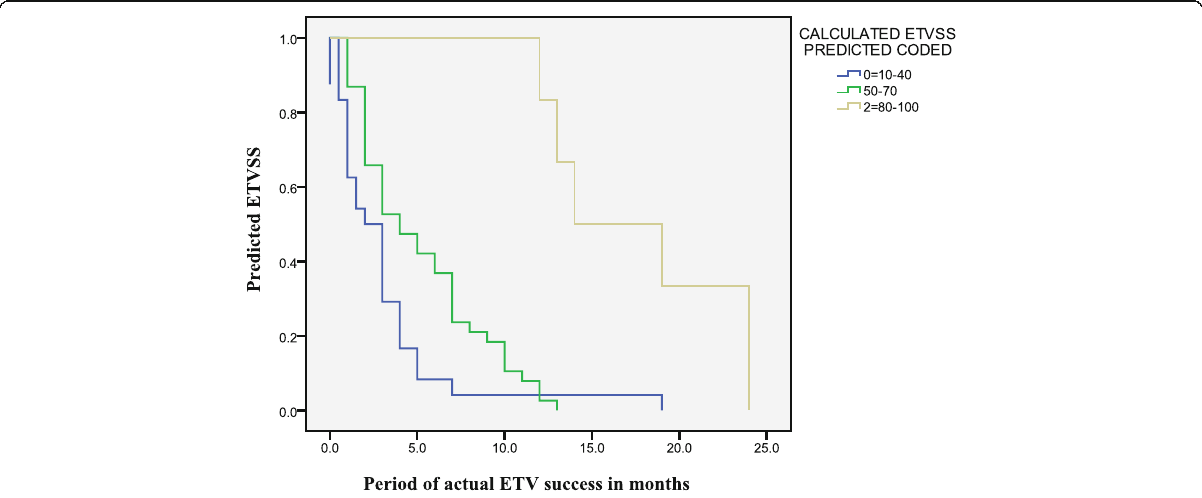
Fig. 2 The Kaplan-Meier survival curve for ETV in 68 patients stratified by